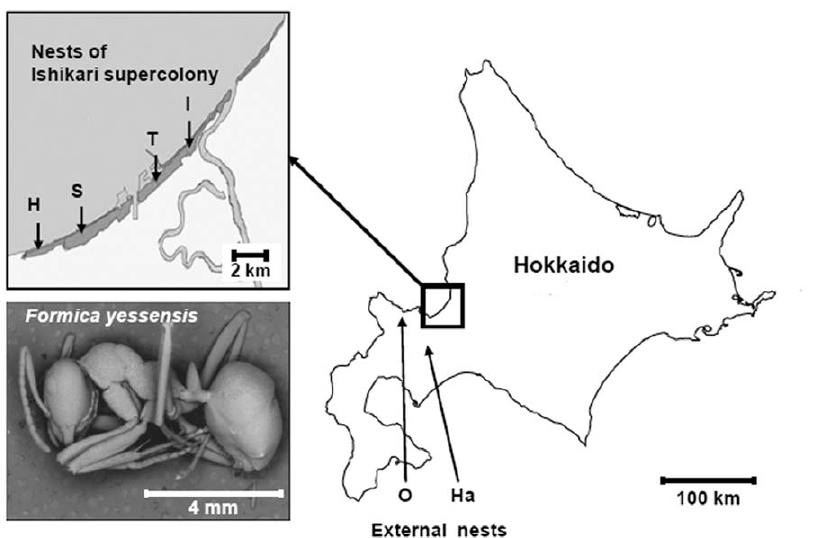
Figure 1. Sampling localities of F.yessensis . Location of the ‘‘Ishikari supercolony’’ comprising 4 nests: ‘‘Hoshioki’’ (H); ‘‘Shinkawa’’ (S); ‘‘Tarukawa’’ (T); ‘‘Ishikari’’ (I), and the 2 independent nests, ‘‘Oshoro’’ (O); ‘‘Hakkenzan’’ (Ha), outside the ‘‘Ishikari supercolony’’. The same letters are used to indicate these nests in Figures 2, 5 and 8. Inset is a scanning electron micrograph (SEM) of a worker of F. yessensis .